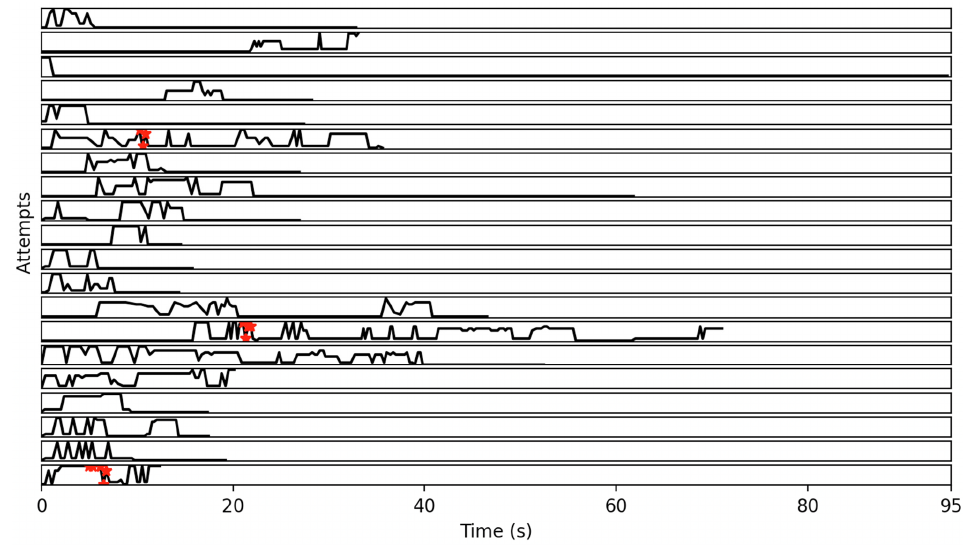
Figure 11. The occurrences of string “806”, as well as its equivalent strings, are indicated in red color in 20 eligible attempts, randomly selected. In all, 124 occurrences of string “806”, as well as its equivalent strings, appear, including a total number of 604 complete frames distributed per robot modality values as follows: (a) Animation (None (279), Disappointed (22), Default (213), Stand (90)), (b) Sound (NO (377), YES (227)), (c) LEDs (NO (589), YES (15)), and (d) Speaking (NO (276), YES (328)) as shown in Figure 12, which displays the results in all 90 attempts. In particular, Figure 12 displays how the possible values of each modality are distributed, for the frames where the pattern “806” and equivalent patterns occur (i.e., for the particular equivalence class). It can be noted that the most frequent pattern “806” rarely appears with LEDs robot modality. The latter is explained by the fact that LEDs fully absorb a child’s attention. Furthermore, Figure 12 shows that the pattern “806” rather appears with either Speaking or Sound. The latter can suggest a pattern of interest to clinical psychologists for further study. It has been observed that the most frequent equivalent patterns are similar, except for two major differences: first, the order of appearance of the states, and second, the number of repetitions of a state before the transition to a new state. The first difference indicates that certain state transitions are more common than others, regardless of the order of their appearance. By knowing what the states represent—in this case a head pose—the expert can identify the meaning of repeated state changes in behavioral terms. The second difference indicates that a pattern of states can have a variable duration because a child may remain in a particular state for some time as was explained above. The developed software allows for the correlation of a particular pattern of states with the robot actions, i.e., to identify which robot actions were active for the duration of the state sequence in question. In this way, the expert can make assumptions on whether specific robot actions cause certain repeated behaviors. For example, the histograms of Figure 12 reveal the active robot actions when pattern ‘806 ′ occurred. In particular, it can be seen that the particular pattern of states occurred more frequently when the robot was speaking and the animation was set to the default mode, i.e., when there were random hand gestures while the robot was speaking.